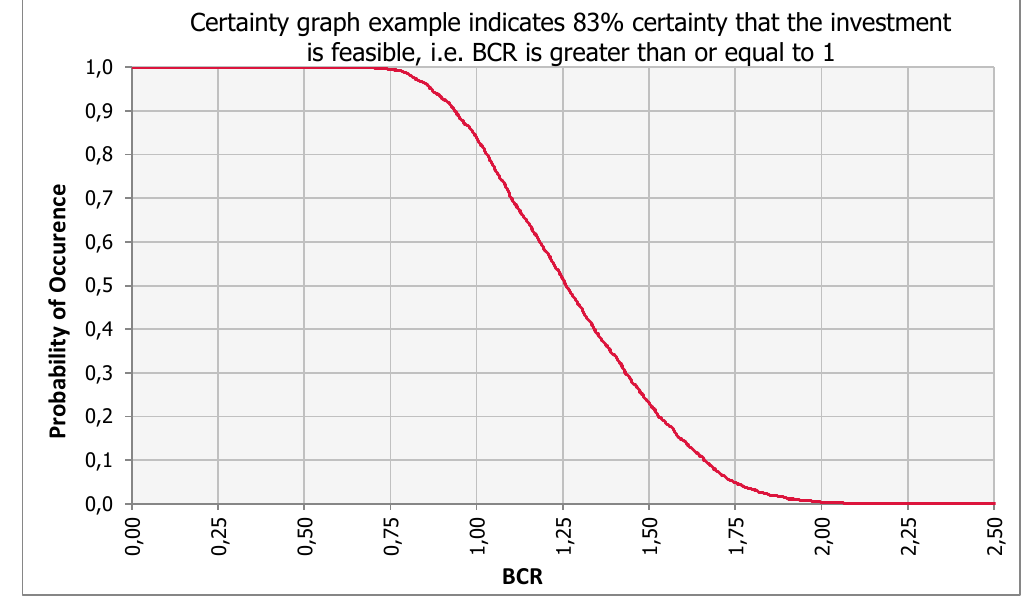
Figure 1. The concept of a certainty